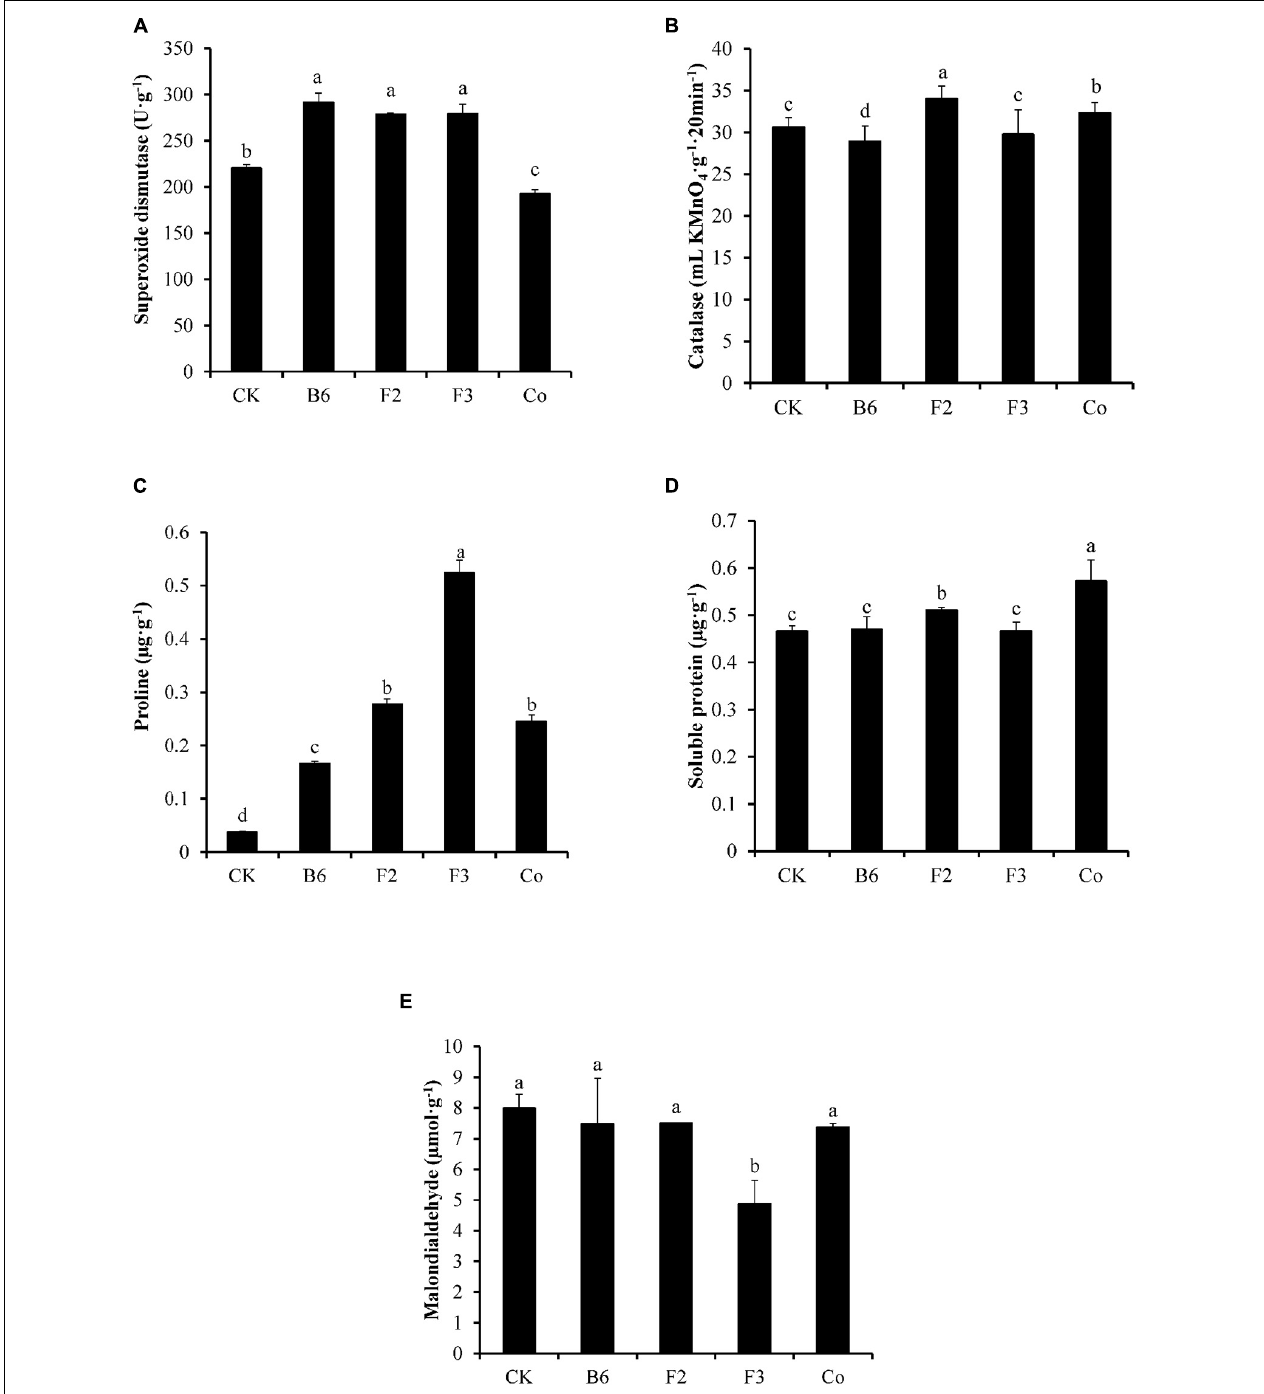
FIGURE 2 | Effects of inoculation different microbes on the physiological index for plant stress tolerance. CK, uninoculated; B6, Bacillus sp.; F2, Clonostachys rosea ; F3, Aspergillus niger ; Co, Co-inoculation with Bacillus sp. and Aspergillus niger . (A) Superoxide dismutase, (B) Catalase, (C) Proline, (D) Soluble protein, and (E) Malondialdehyde. Different letters indicate that the values differed significantly at p < 0.05. The values represent the mean ± SD ( n = 4).